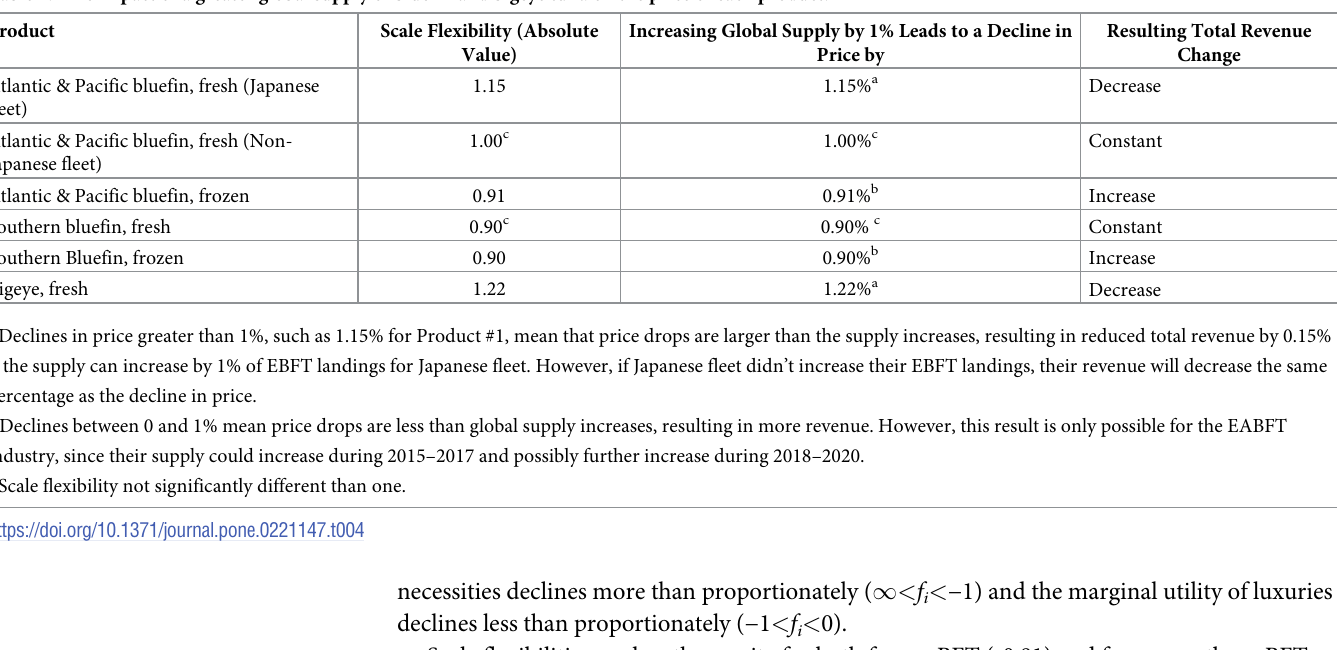
Table 4. The impact of a greater global supply of bluefin and bigeye tuna on the price of each